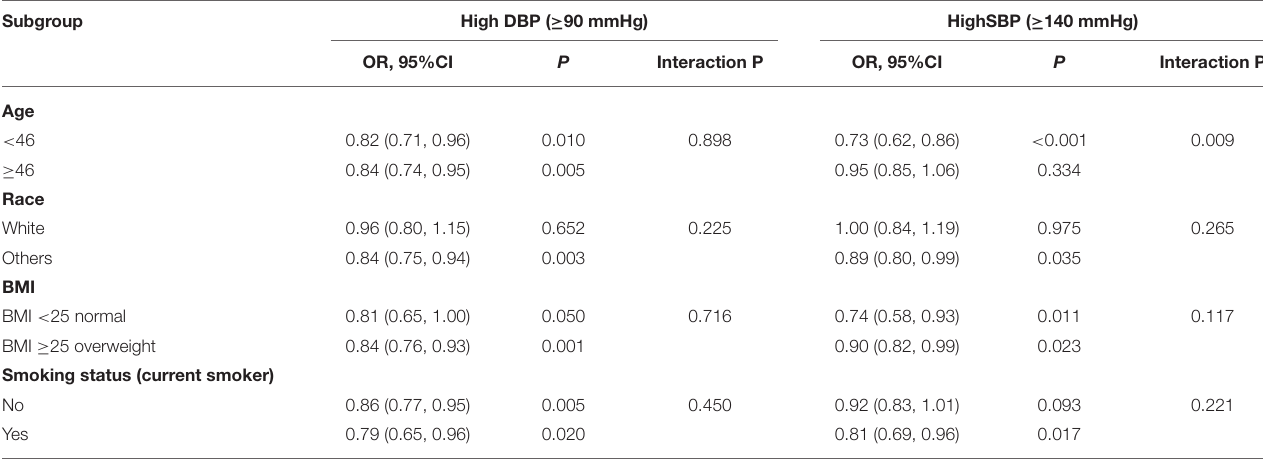
TABLE 5 | Multiple logistic regression analysis for relationship between DDE fiber from grains and risk of hypertension stratified by age, race, BMI and current smoker prespectively.